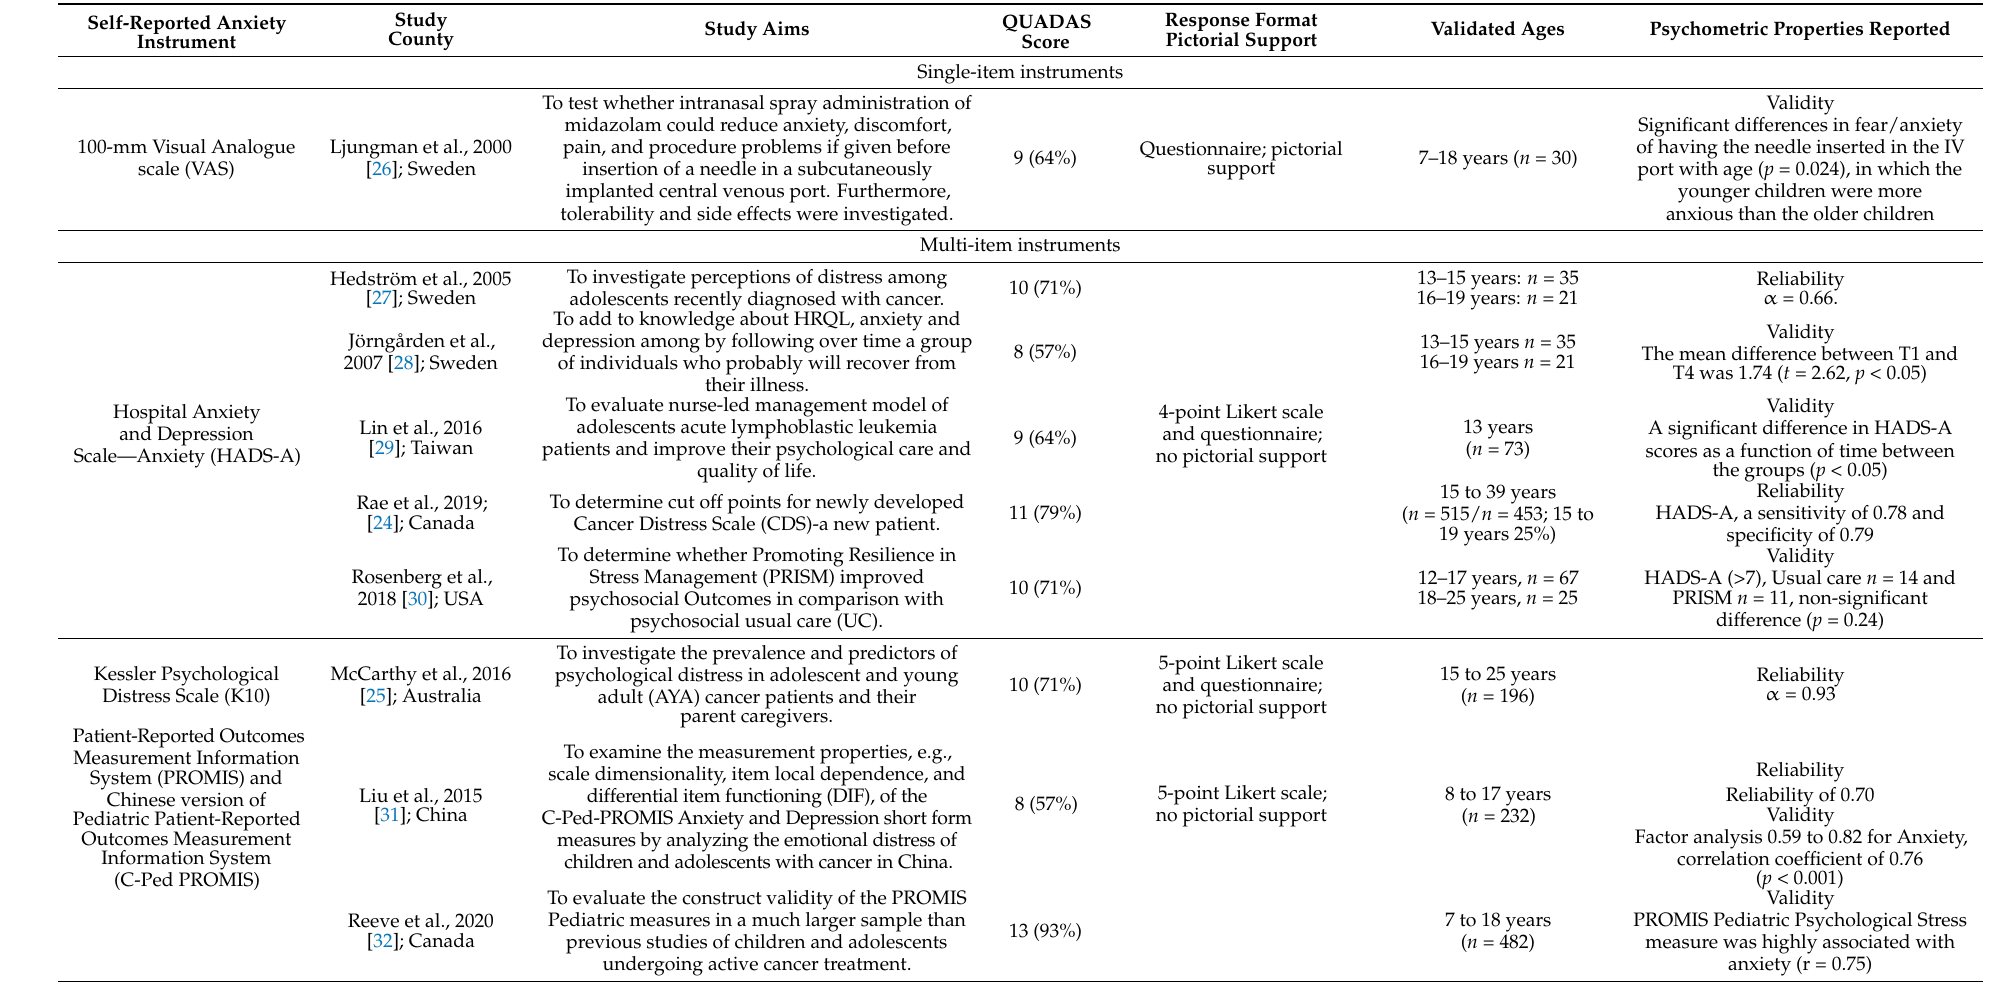
Table 2. Characteristics and psychometric properties of selected studies and reported